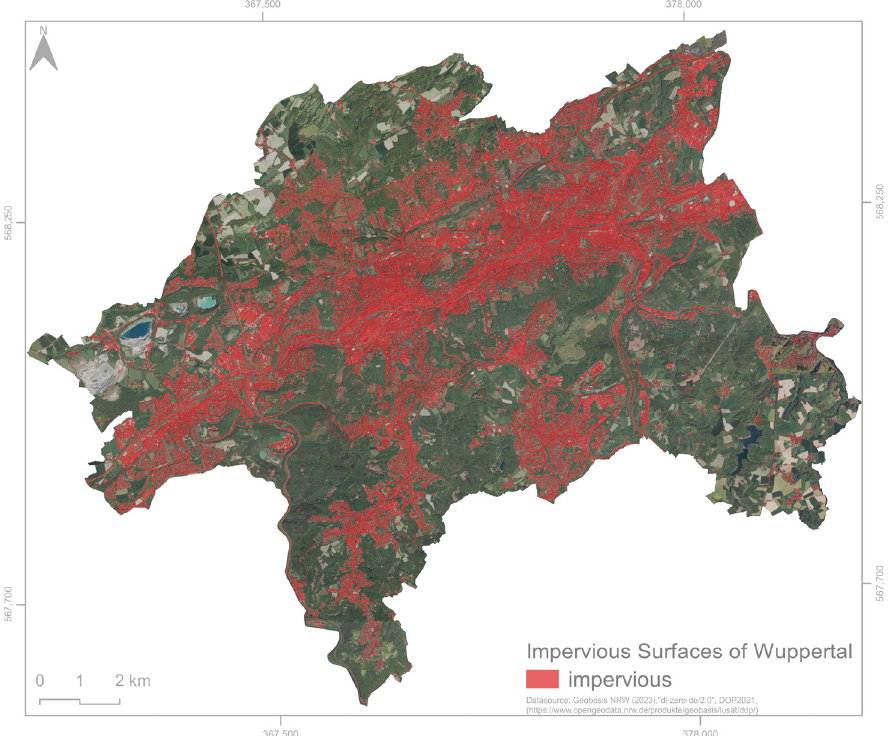
Figure 7. Very high-resolution spatially explicit map of impervious surfaces in the city of Wuppertal.